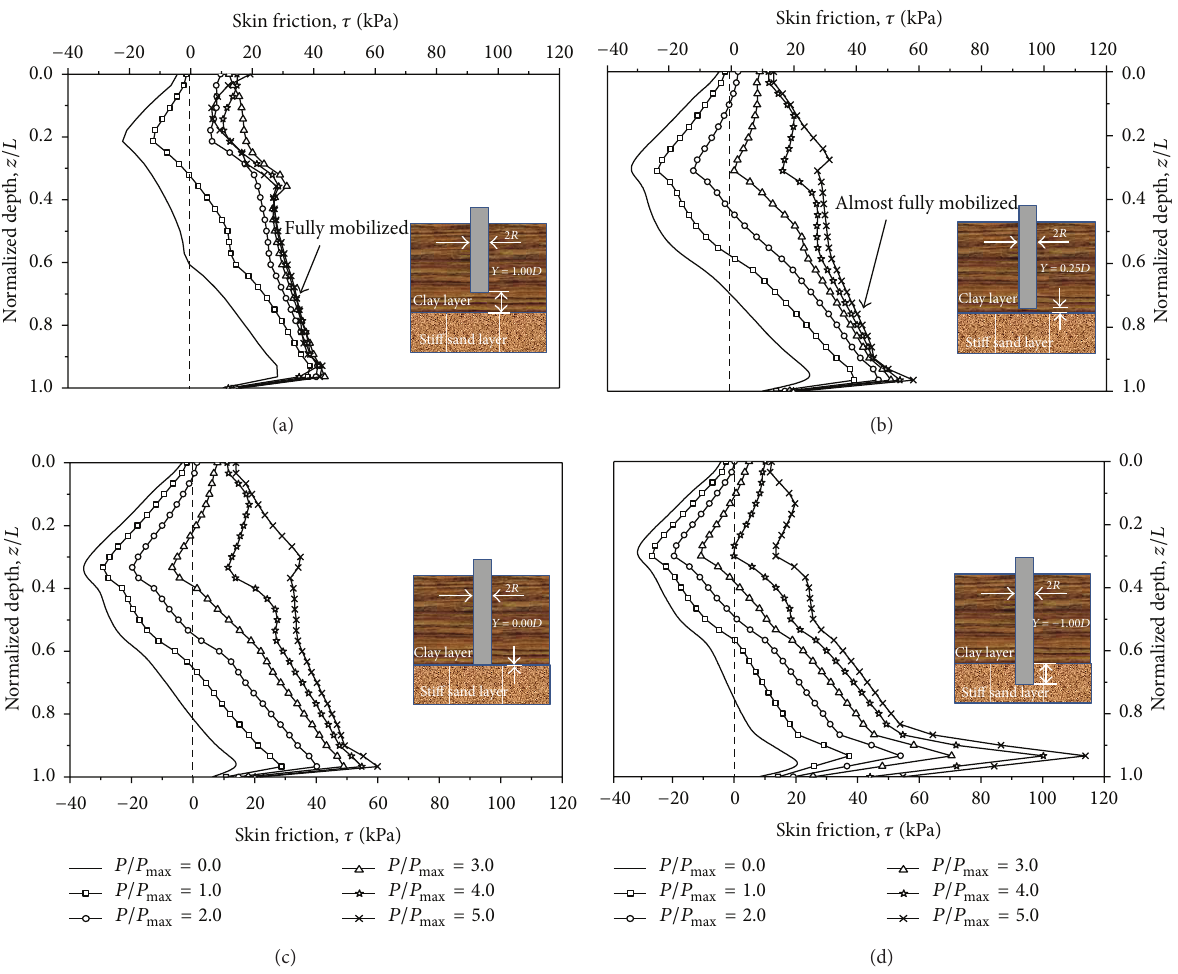
Figure11:Computedvariationoftheskinfrictionofapilewithtiplocation:(a) 𝑌 = 1.00𝐷 ,(b) 𝑌 = 0.25𝐷 ,(c) 𝑌 = 0.00𝐷 ,and(d) 𝑌 = −1.00𝐷